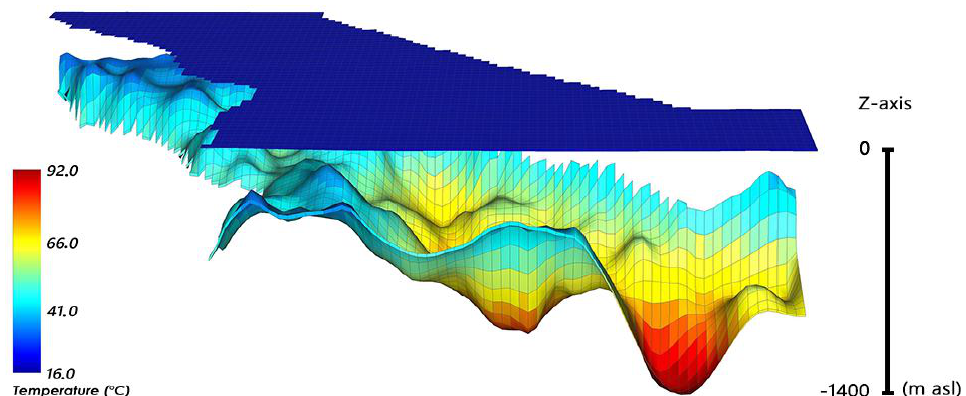
Figure 8. 3D visualization of input temperatures for top and bottom layers of the model: the upper layer coincides with the topographic surface (DTM), while the bottom layer is the top of bedrock. The simulation volume is the same as in Figure 7; see also Figure 5 for isobaths of bedrock top.